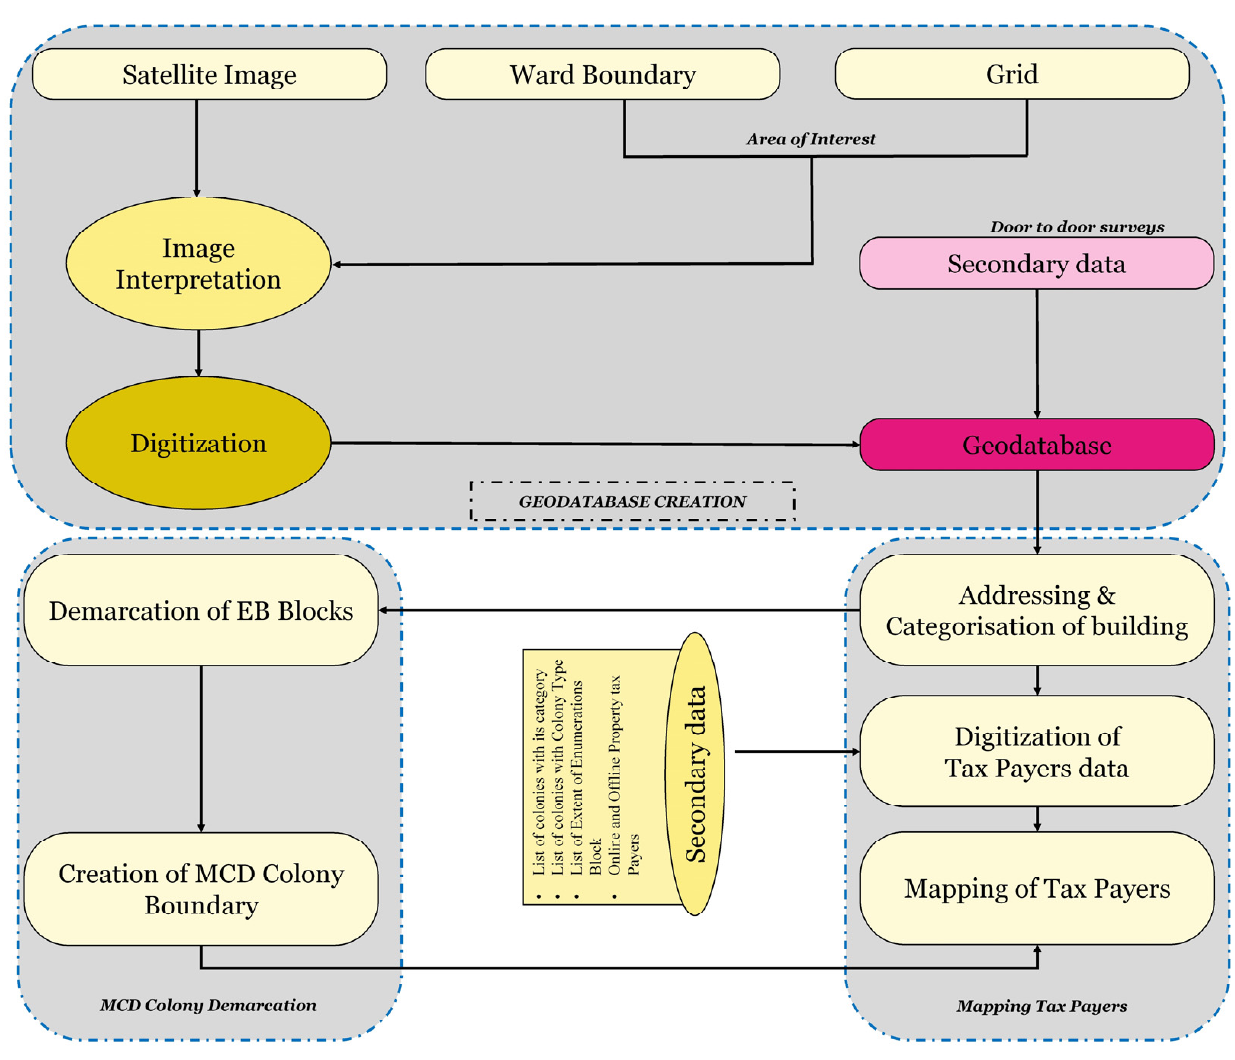
Figure 2. Overall methodology opted for in the present study.